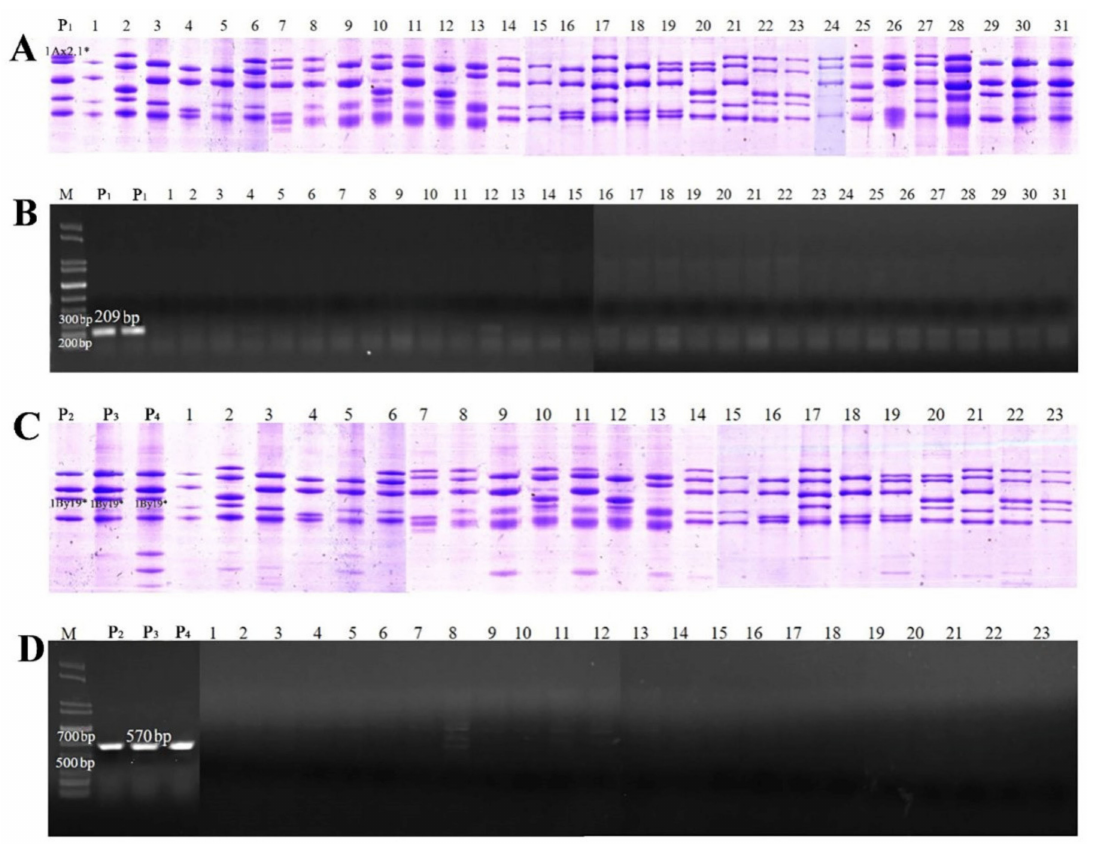
Figure 6. Development of the SNP-based molecular markers for 1Ax2.1* and 1By19* genes. ( A ) Identification of 1Ax2.1* subunit in different wheat varieties by SDS-PAGE. ( B ) PCR amplifi- cation of 1Ax2.1* gene from different wheat varieties by the primer 2.1*F/R. The 209 bp specific amplified fragment is indicated. ( C ) Identification of 1By19* subunit in different wheat varieties by SDS-PAGE. ( D ) PCR amplification of 1By19* gene from different wheat varieties by the primer 19*F/R. The 570 bp specific amplified fragment is indicated. The varied numbers in the figure are the same as those in Table S1. P 1 : Spelt 137; P 2 : Spelt 6; P 3 : Spelt 20; P 4 : Spelt